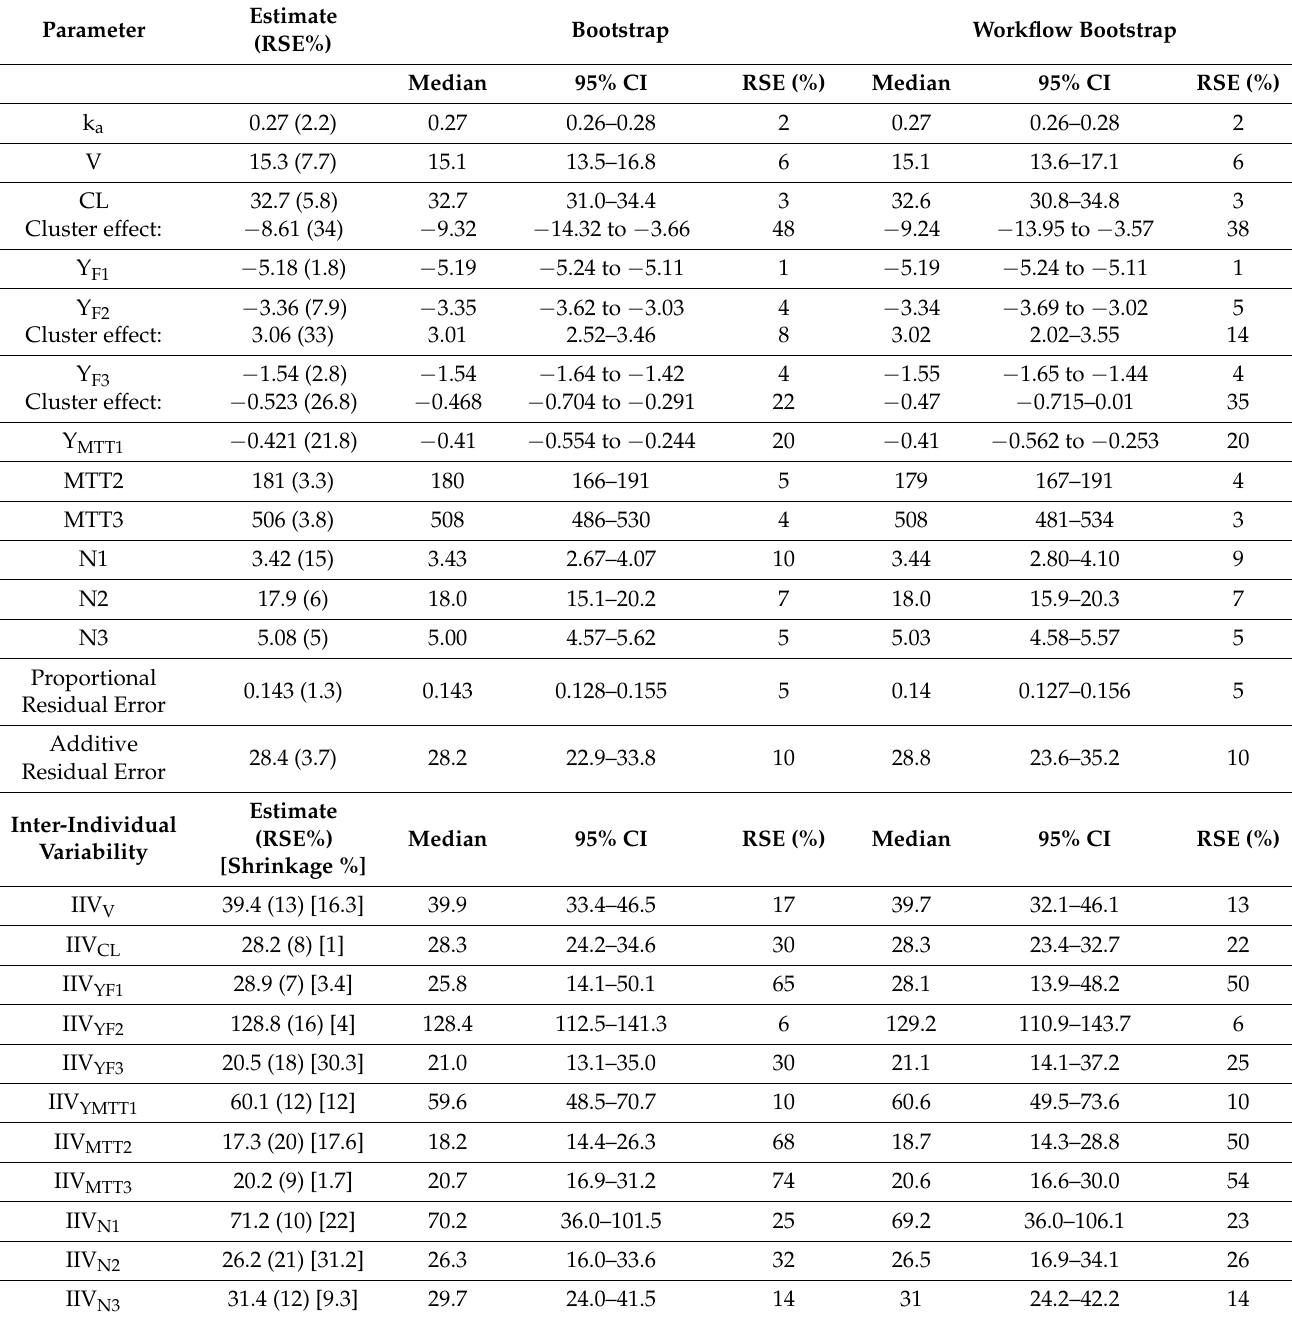
Table 2. Parameter estimates of the final model and the corresponding inter-individual variability. Relative standard errors and bootstrap confidence intervals are also